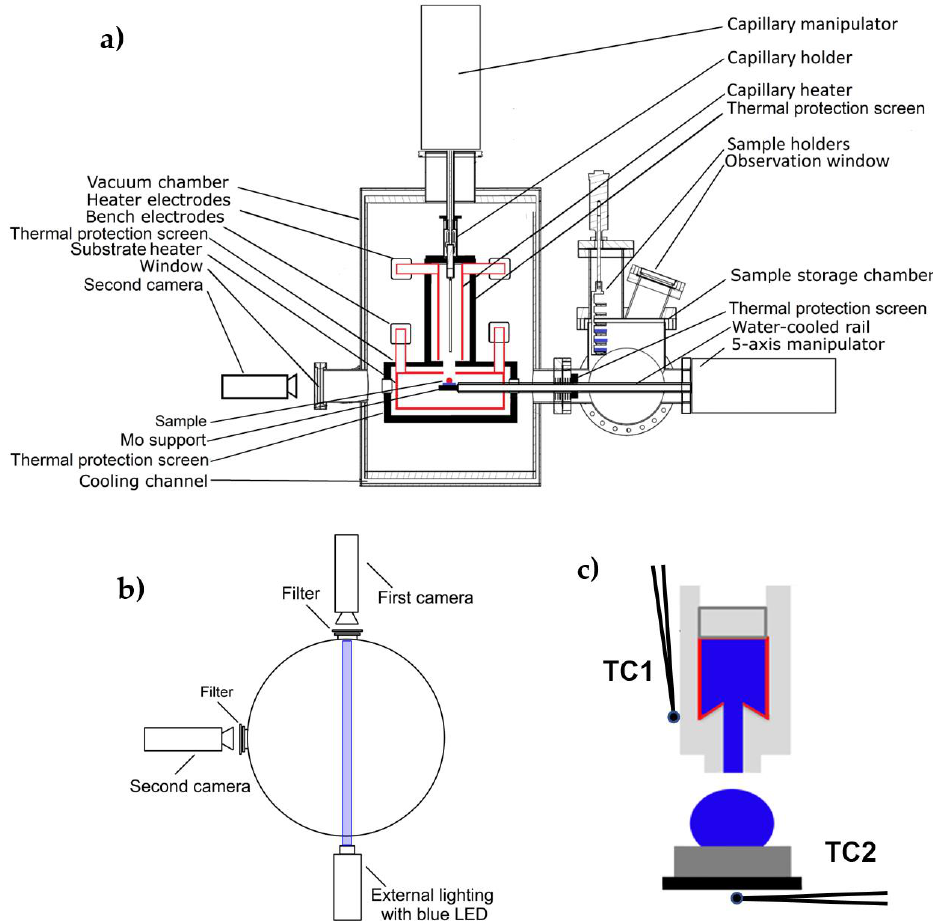
Figure 1. Schematic presentation of the apparatus used for real-time observation of high-temperature phenomena taking place during the interaction of molten materials with dissimilar substrates [45]: ( a ) side-view, ( b ) top-view, ( c ) location of thermocouples at the capillary (TC1) and under the test substrate (TC2).